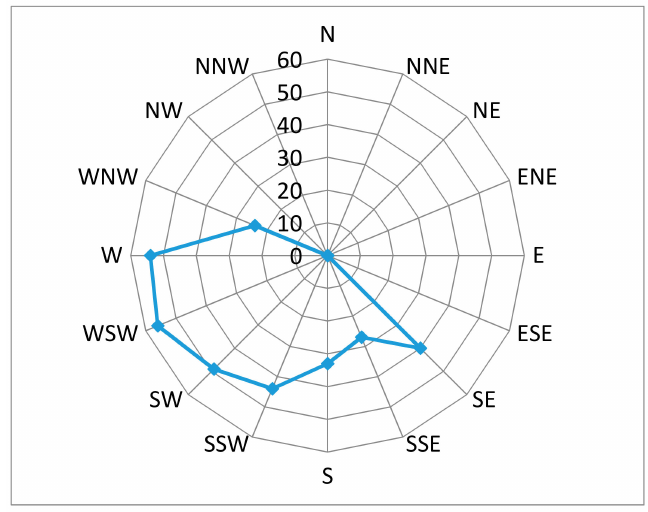
Figure 3. Rose diagram of five-day averaged values of O 3 ( µ g/m 3 ) versus wind direction. Personal ozone levels have been recorded to be significantly lower than the limit